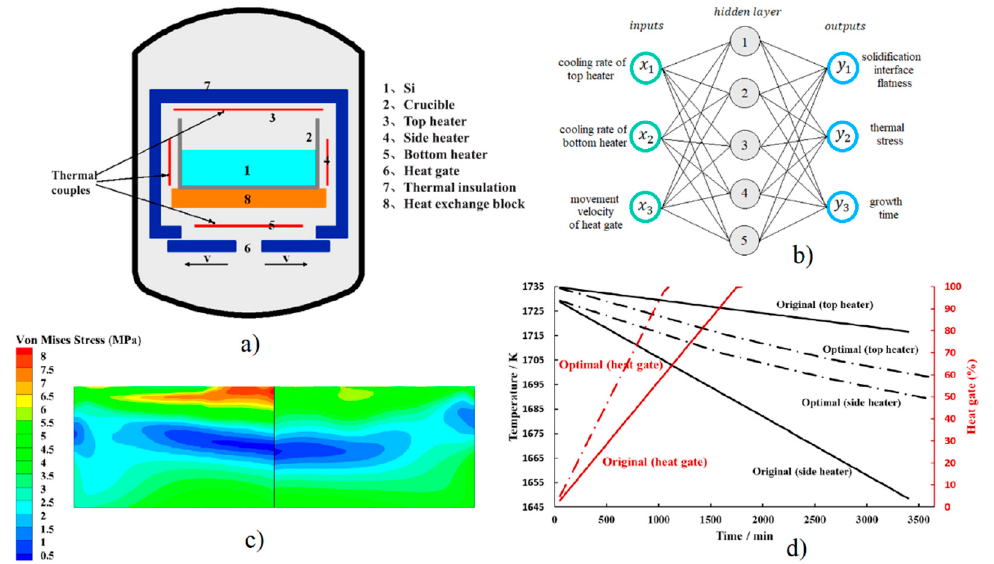
Figure 10. Optimization of controlling recipe in quasi-mono Si growth using feed-forward ANN coupled with GA: ( a ) Configuration of a G6-size industrial seeded directional solidification (DS) furnace, ( b ) ANN architecture, ( c ) thermal stress field in the grown crystals between the original controlling recipe (left) and the optimal recipe (right), ( d ) original and the optimal growth recipe. Reprinted from [31] with permission from Elsevier.